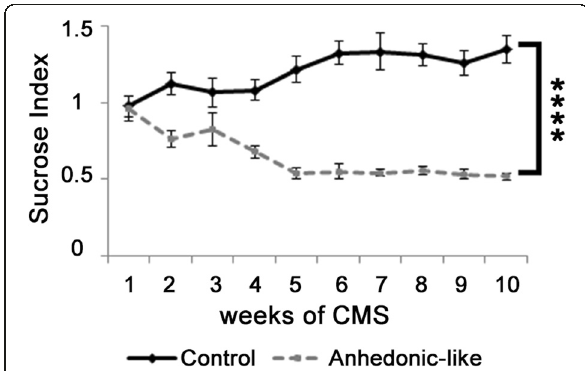
Fig. 2 Sucrose Index. Sucrose consumption data indexed to individual baseline values. Data are given as mean +/ − SEM. Control rats ( n =10) and anhedonia-like rats ( n =10). Anhedonia-like rats have significantly lower sucrose intake than control rats shown by RM-ANOVA (F(1,18)=67.105, p <0.0001). Pair-wise differences were demonstrated at weeks 2, 4 – 10 by Bonferroni ’ s post hoc